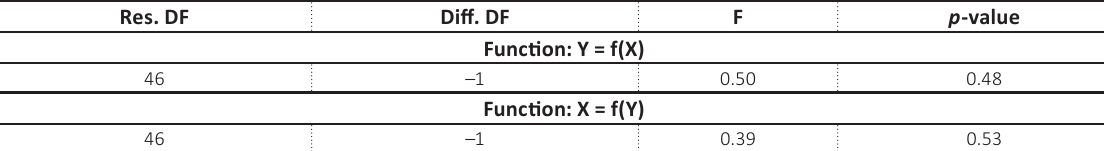
Table E2. Ranking in 50 largest economies (X) and SDGI score 2016 (Y) Res. DF